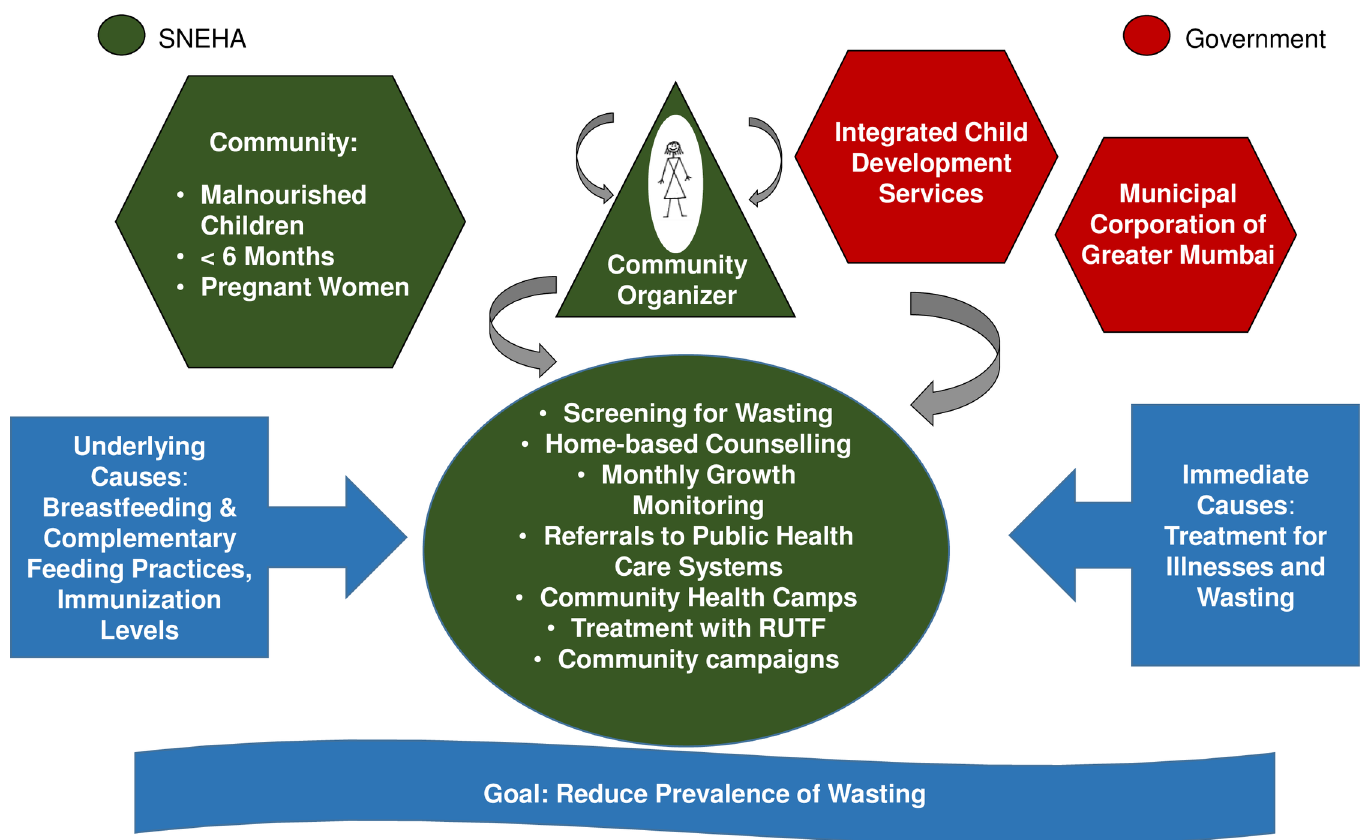
Fig 1. SNEHA program partnerships and key activities. Abbreviations: RUTF, Ready-to-use therapeutic food; SNEHA, Society for Nutrition, Education and Health Action.